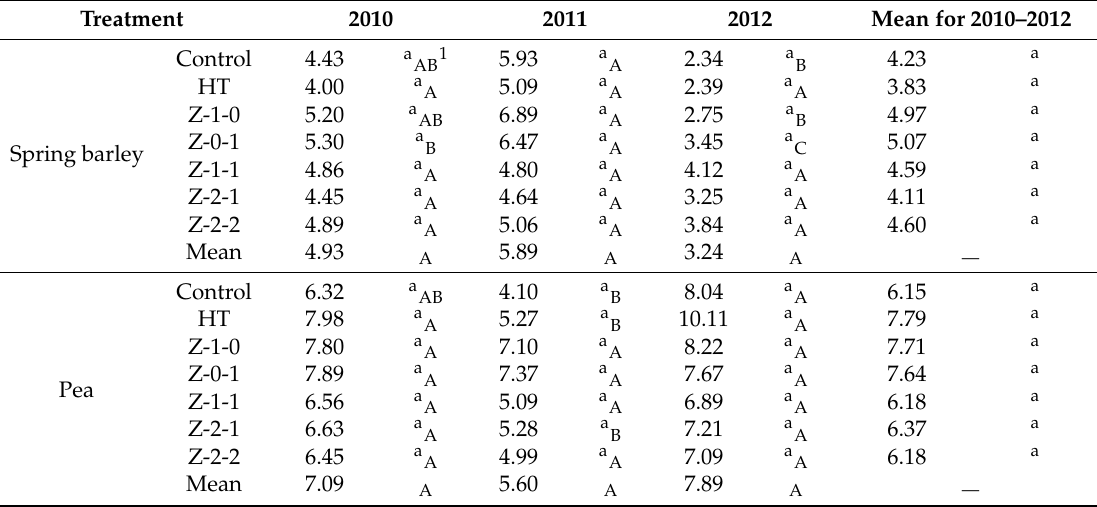
Table 2. The average moisture of spring barley and pea grains